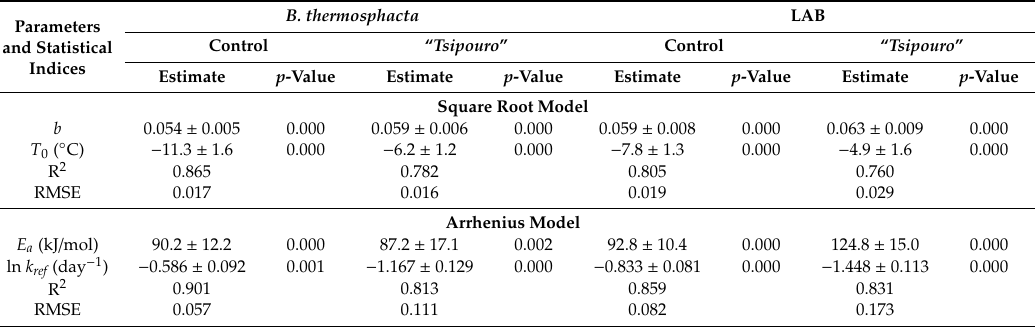
Table 2. Estimated parameters and statistics of the developed secondary square root growth models and Arrhenius models of B. thermosphacta and LAB on ground beef (500 g) packaged with absorbent cloths supplemented with 50 mL of “ tsipouro ” (40 mL under the ground beef piece and 10 mL under the labelling, facing the headspace) and stored at 0, 4, 8, and 12 ◦ C under 80% O 2 : 20% CO 2 . Untreated samples served as